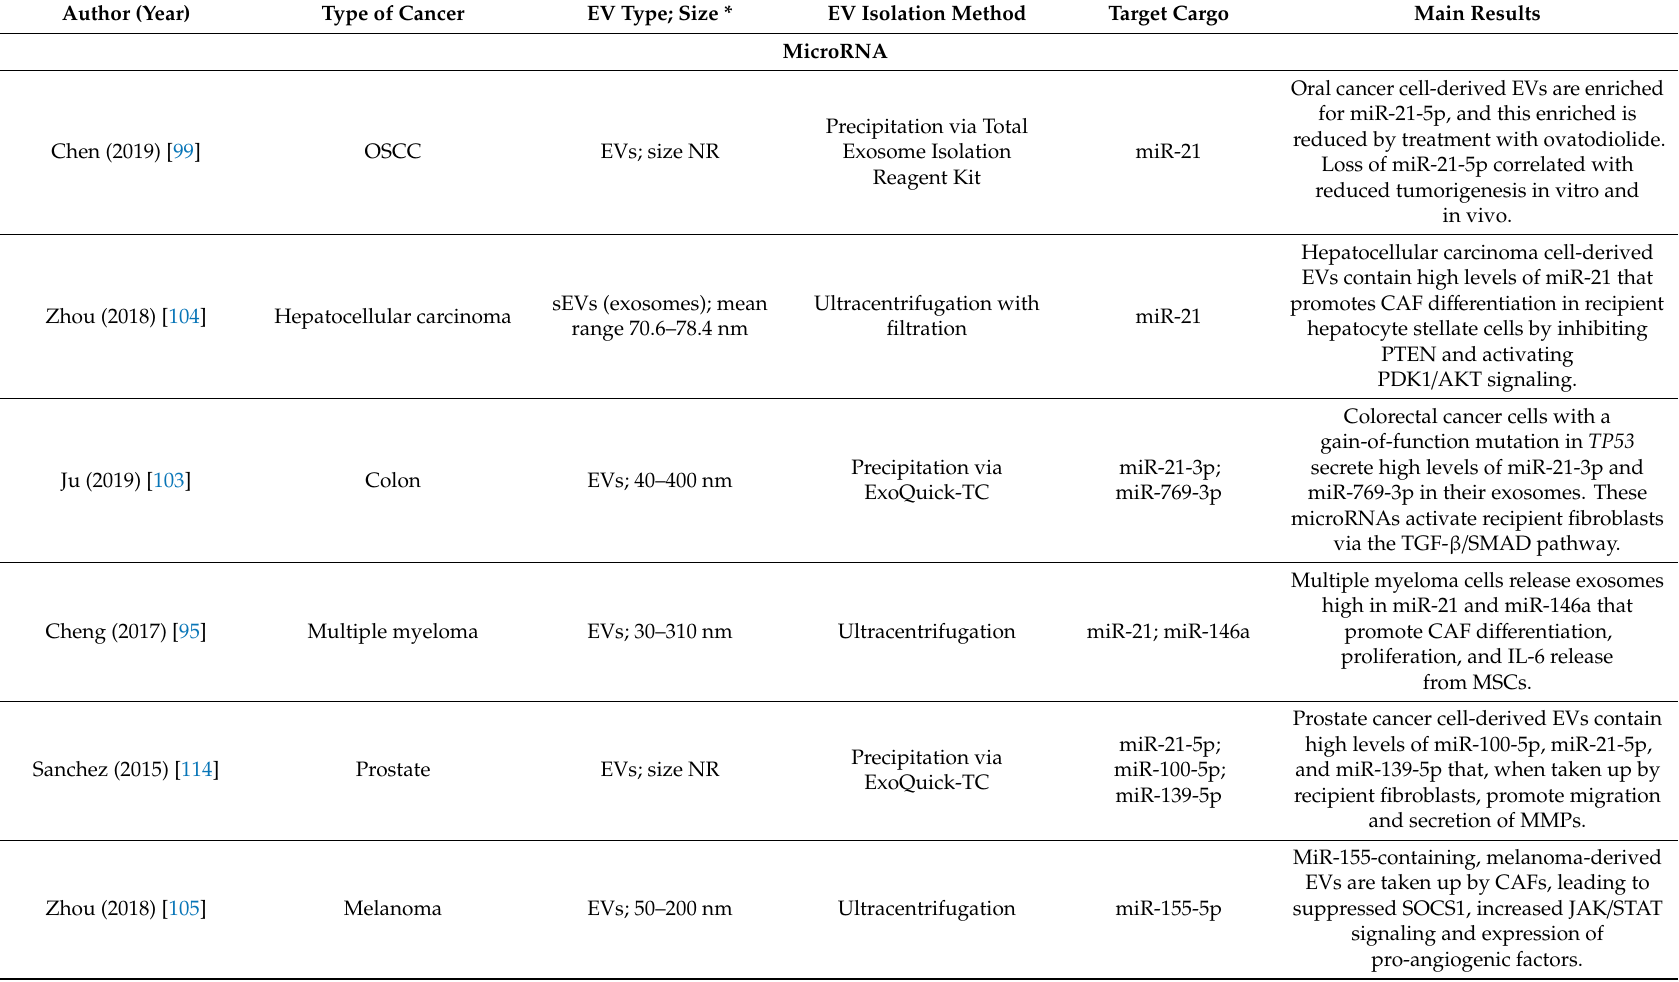
Table 1. Summary of e ff ects of cancer cell-derived extracellular vesicles on stromal